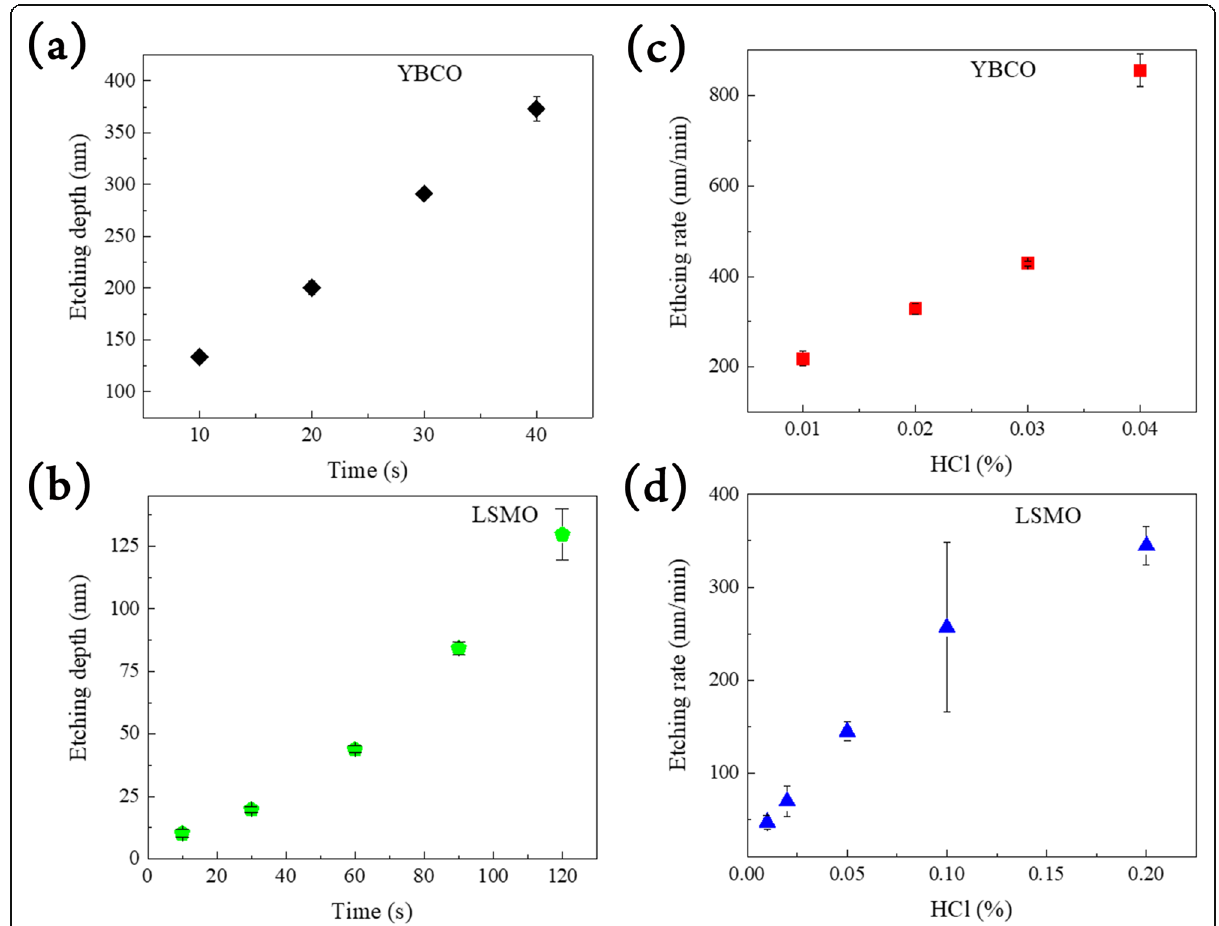
Fig. 4 Etching depth versus time for a YBCO and b LSMO, respectively. HCl concentration-dependent etching rate of c YBCO and d